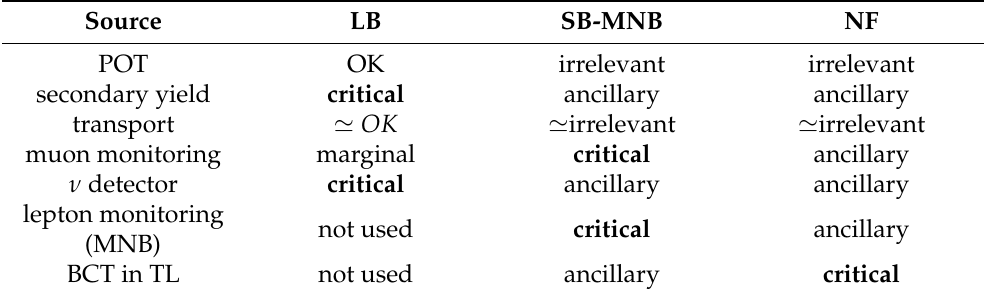
Table 2. Diagnostics in long-baseline (LB), short-baseline with monitored neutrino beams (SB-MNB) and Neutrino Factories (NF). The leading diagnostic tool driving the systematic budget is labeled “critical”. The tools that are not needed because sidestepped, for instance by the lepton monitoring, are labeled “irrelevant”. BCT in TL means a Beam Current Transformer located in the transfer line. “ irrelevant” describes cases where the information is not needed at leading order but is useful (cid:39) to estimate second-order effects like kaon (muon) decays before the decay volume (storage ring) in MNB (NF). We labeled “OK” the diagnostic tools that are needed but do not limit the current precision on the